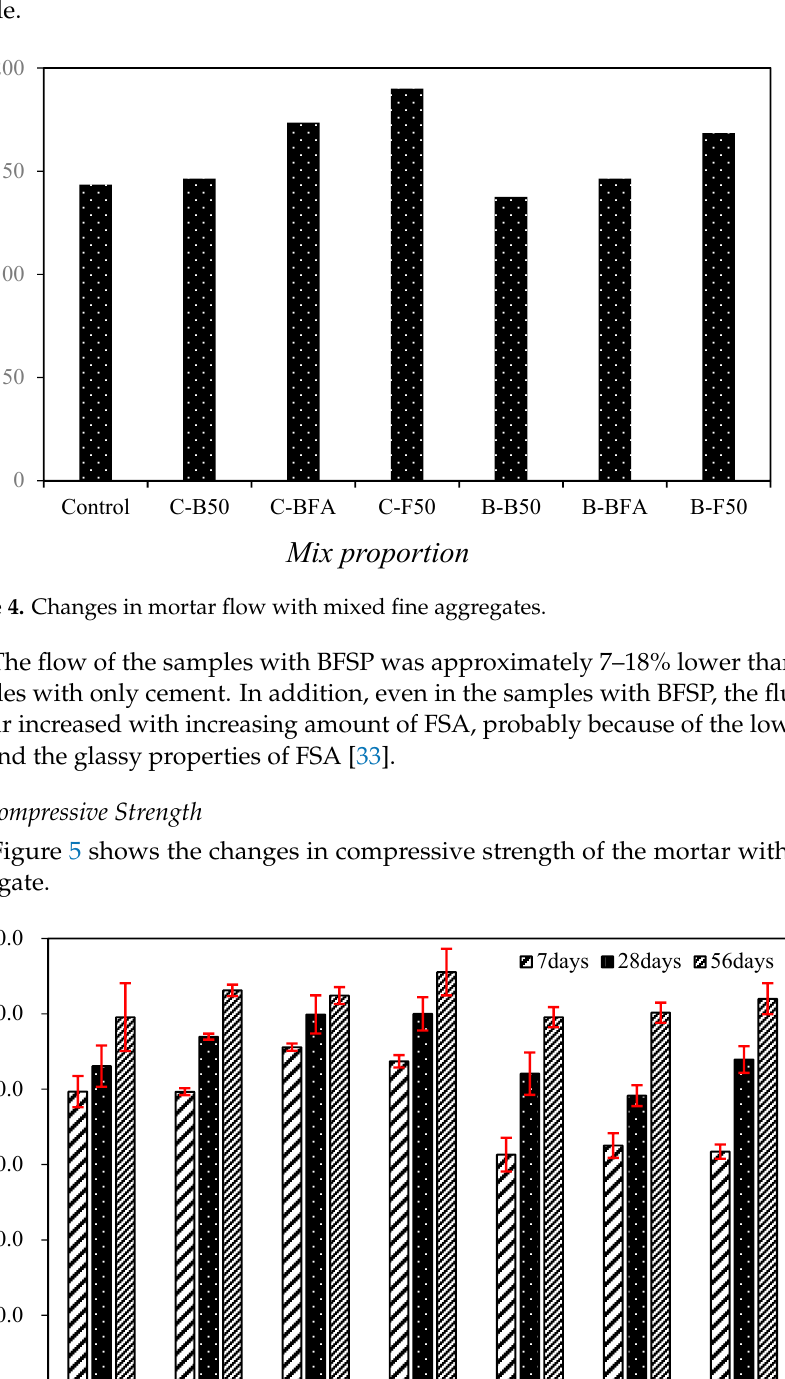
Figure 4. Changes in mortar flow with mixed fine aggregates.